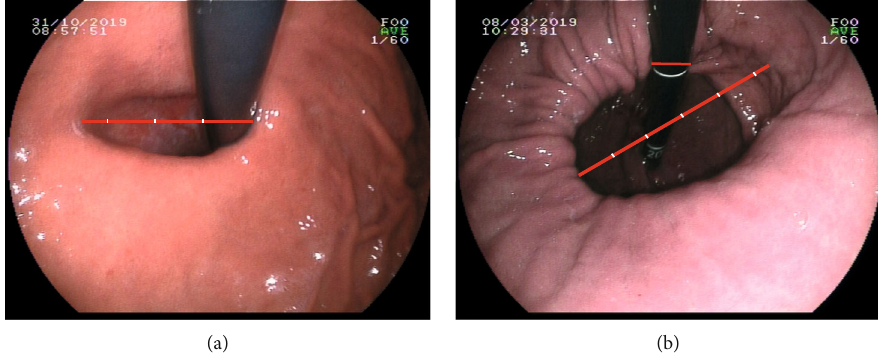
Figure 1: The image of maximum laxity with the long diameter: (a) at the horizontal level showing that the length was about 3.4 of an endoscope (perfect position); (b) not at the horizontal level showing the length of 5.3 of an endoscope (suboptimal position).